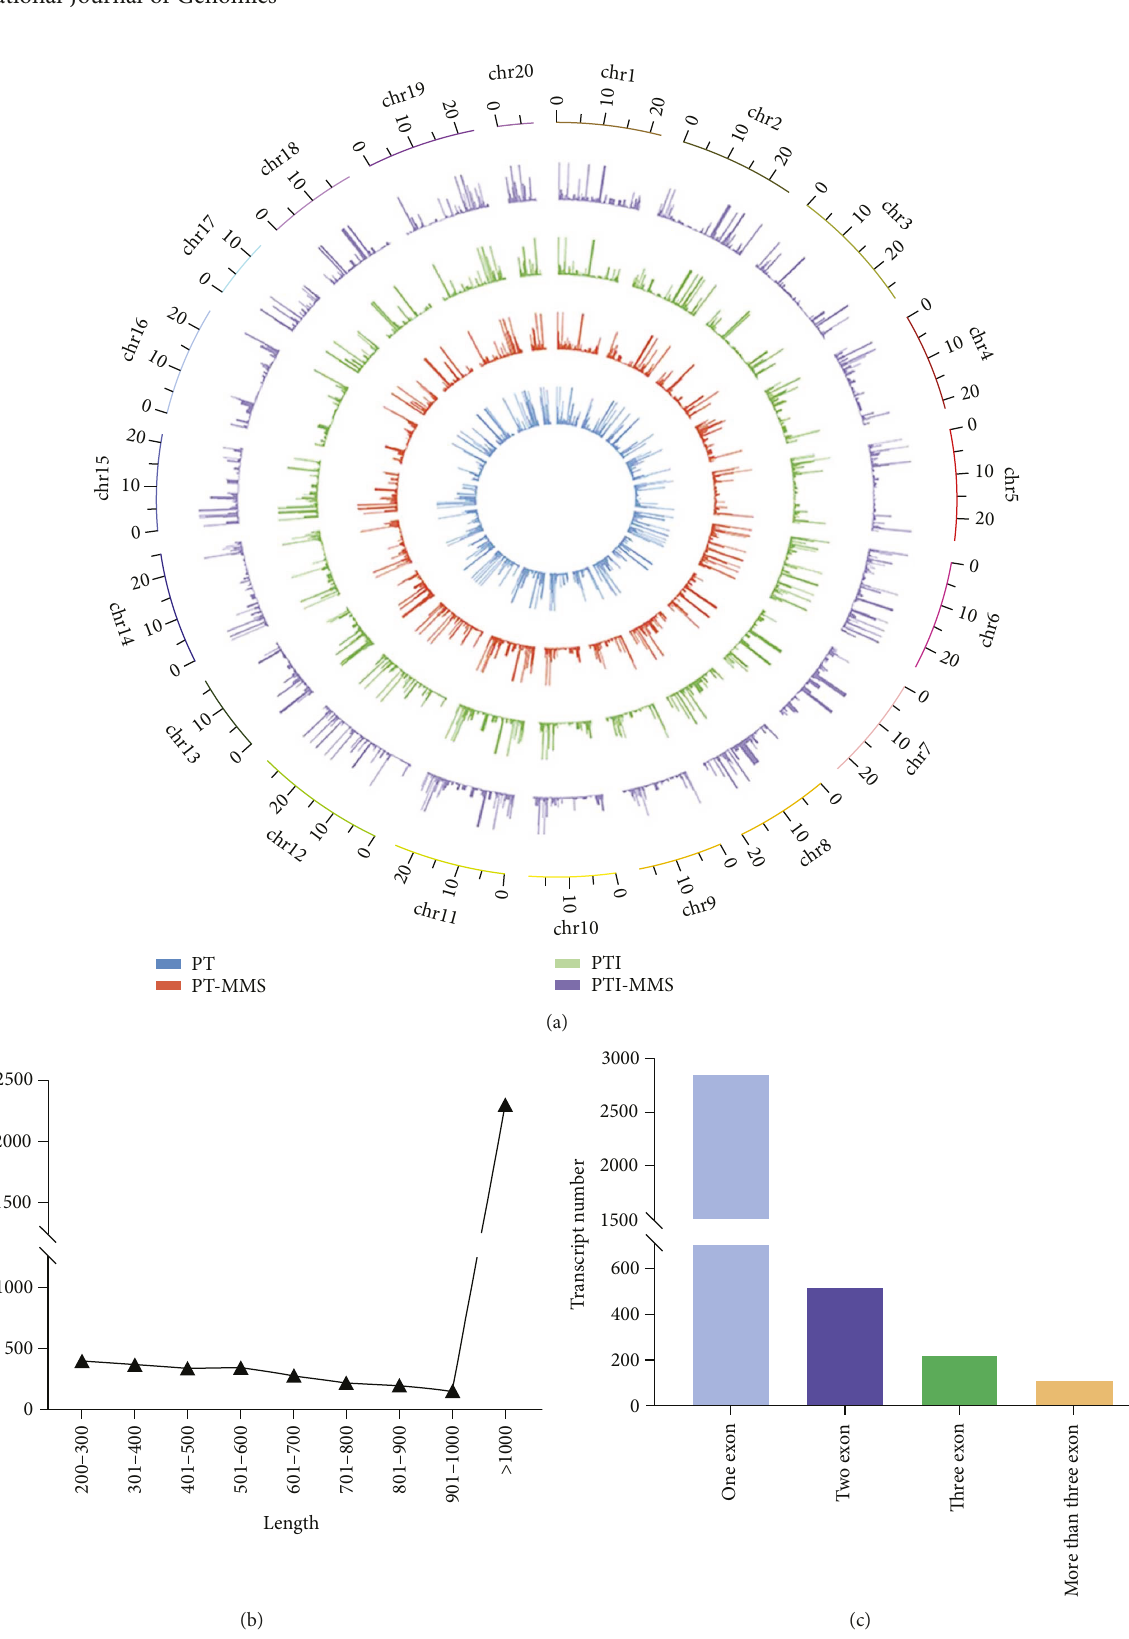
Figure 1: Features of lncRNAs in P. tomentosa . (a) Distribution of lncRNAs along each chromosome. (b) Length distribution of 3689 P. tomentosa lncRNAs. (c) Number of exons per transcript for all lncRNA